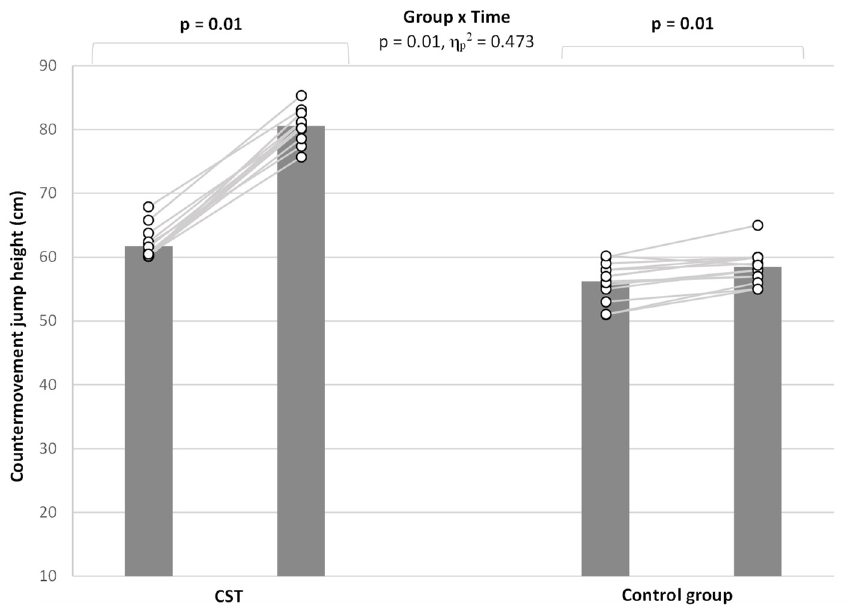
Figure 3. Participants performance before and after intervention of CMJ performance by the two groups.